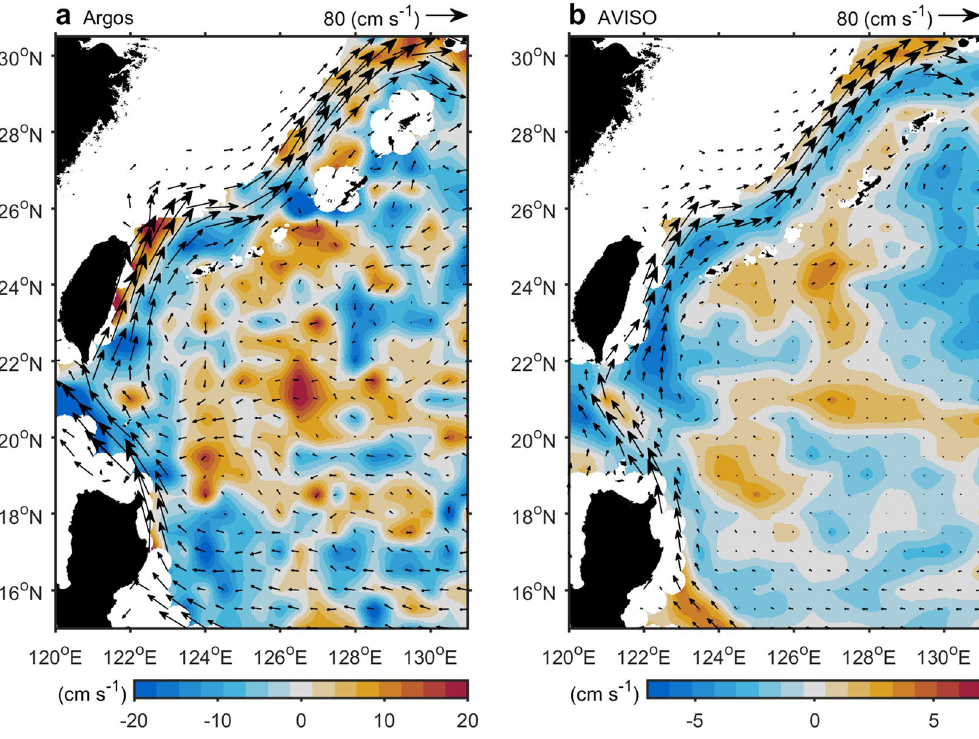
Figure 2. Surface velocity differences between the two periods. Monthly velocity anomaly differences (shading) (1999–2013 minus 1993–1998) from ( a ), Argos and ( b ), AVISO data sets. Vectors indicate long-term mean velocity.